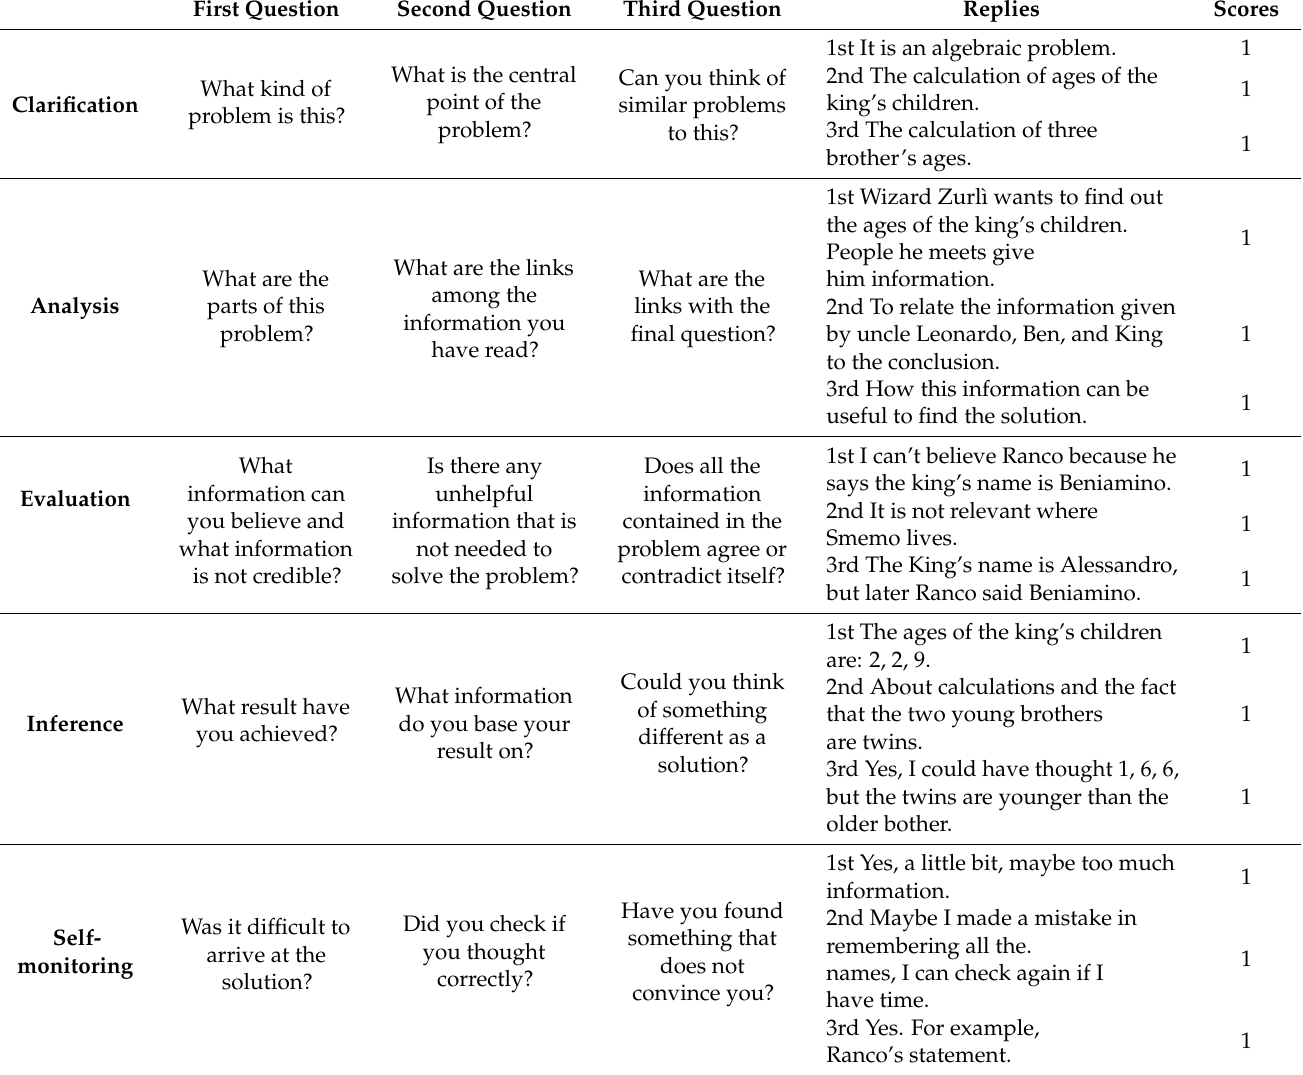
Table 4. Scoring for each question of the mathematical